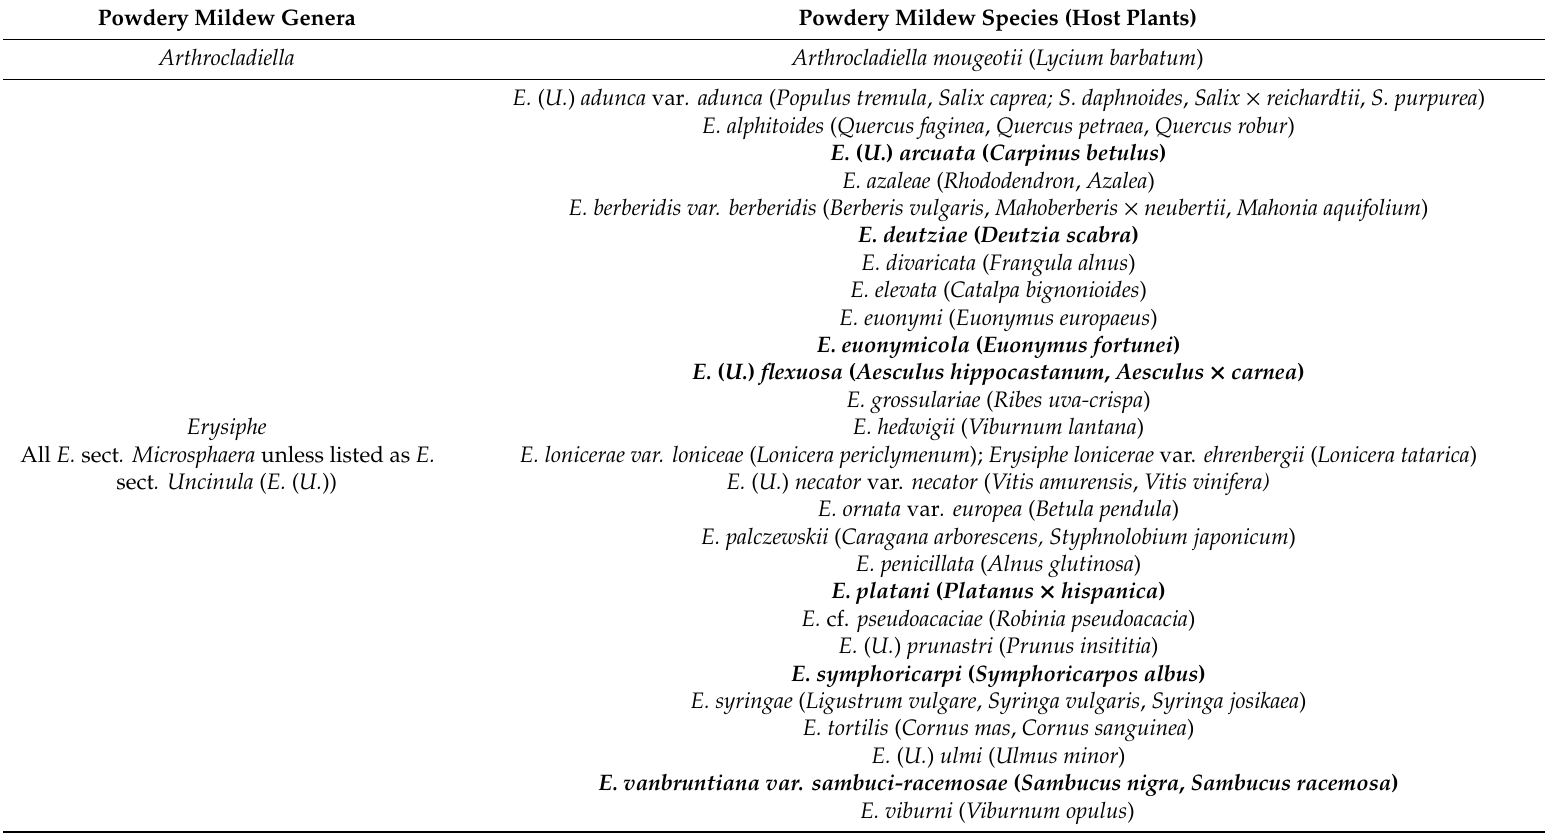
Table 2. List of powdery mildew species collected on trees and shrubs in the Czech Republic with their host